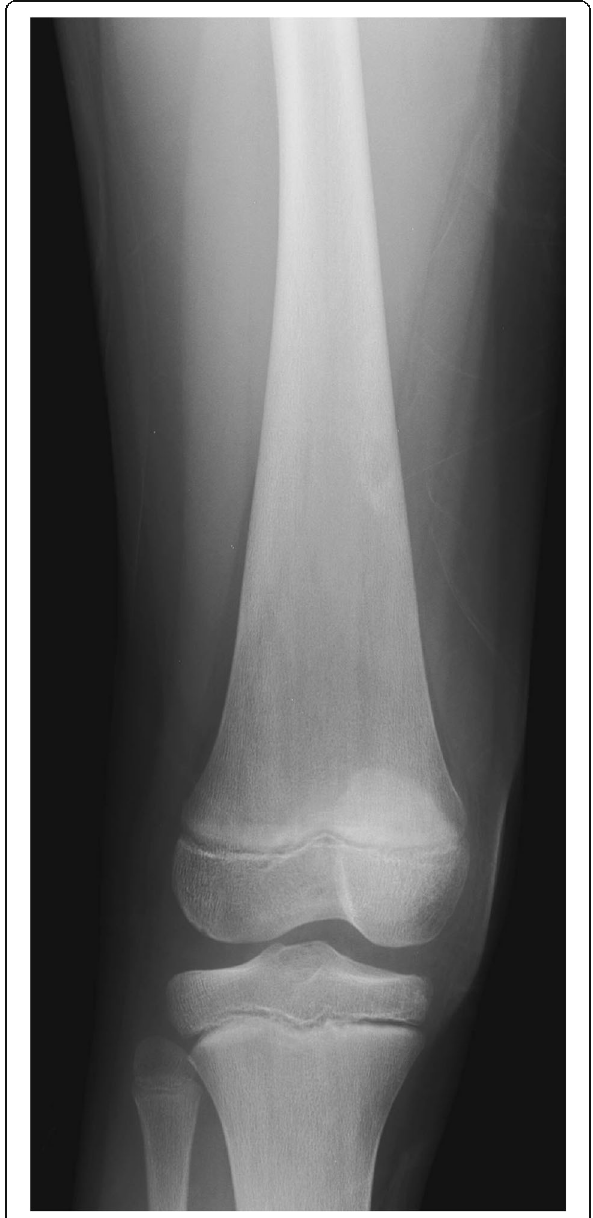
Fig. 7 Erlenmeyer flask deformity. Frontal radiograph of the right knee in a 12-year-old-male Gaucher disease patient with widening of the distal femoral diaphysis and metaphysis resulting in Erlenmeyer flask deformity